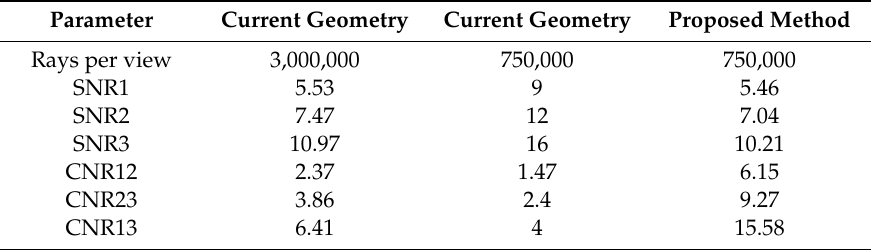
Table 2. Simulation’s results summary.